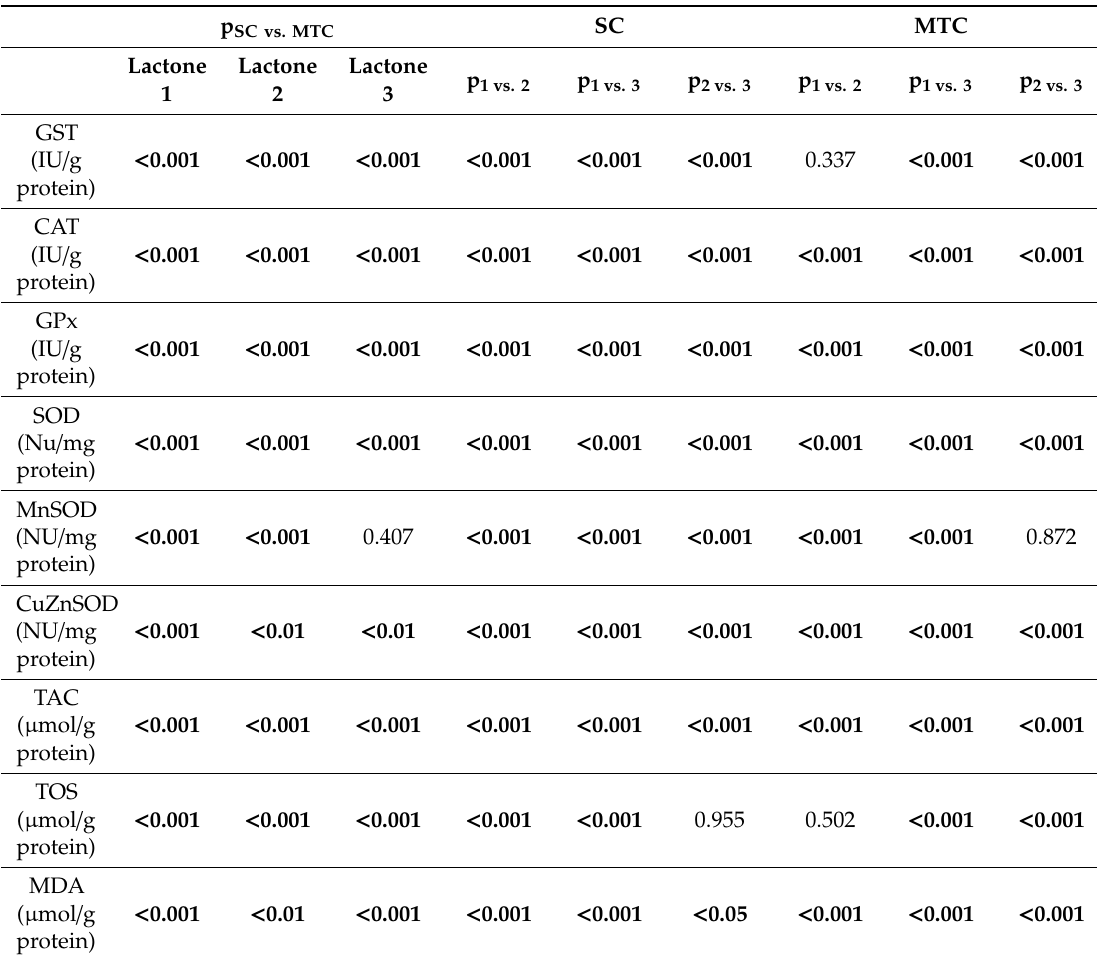
Table 4. Multiple comparisons in contrast analysis. Post hoc analysis of selected oxidative stress markers in NHDF cells exposed to di ff erent concentrations of lactones 1 – 3 (SC—starting concentration, MTC—minimal toxic concentration). Statistical significance was set at p < 0.05. Statistically significant values are